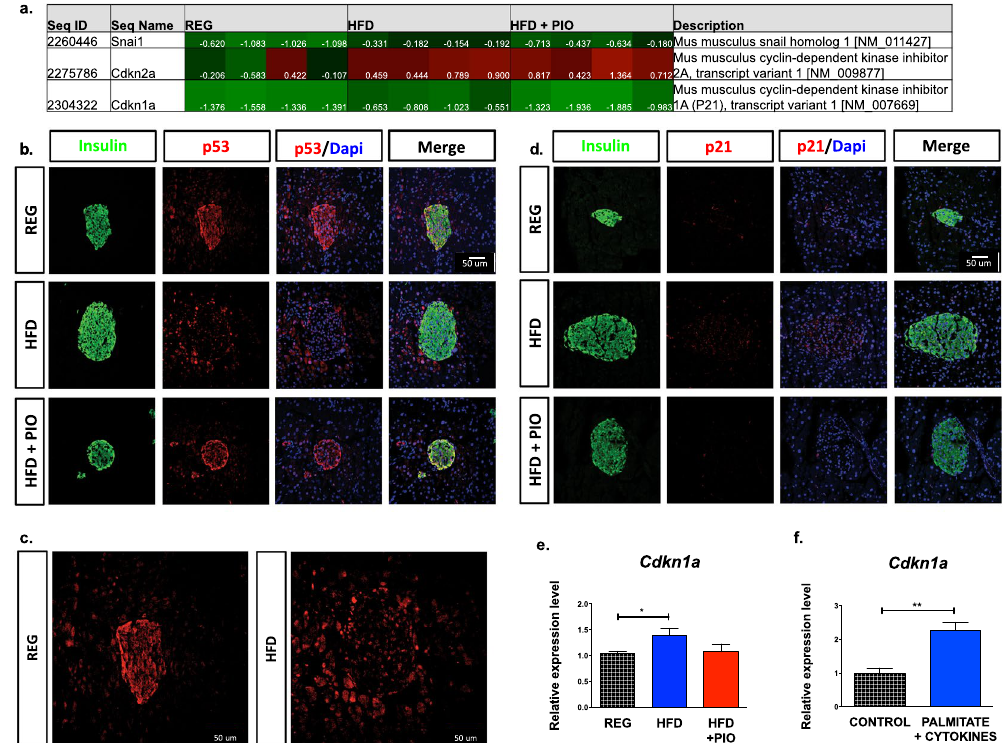
Figure 4. Evidence of p53 activation in islets from HFD treated mice. ( a ) Microarray functional grouping analysis of islets from each diet group. (n = 4) ( b ) Representative immunofluorescent staining of p53, insulin, and DAPI for islets from each treatment group. (n = 3) ( c ) Enlarged image of p53 staining in REG and HFD treatment groups. ( d ) Representative immunofluorescent staining of p21, insulin, and DAPI for islets from each treatment group. (n = 3) ( e ) qRT-PCR analysis of total islet RNA for Cdkn1a expression. (n = 4) ( f ) qRT-PCR analysis for Cdkn1a expression in MIN-6 β cells treated with 40 hours of palmitate + a cytokine mix to mimic chronic lipotoxicity. * p < 0.05, ** p <